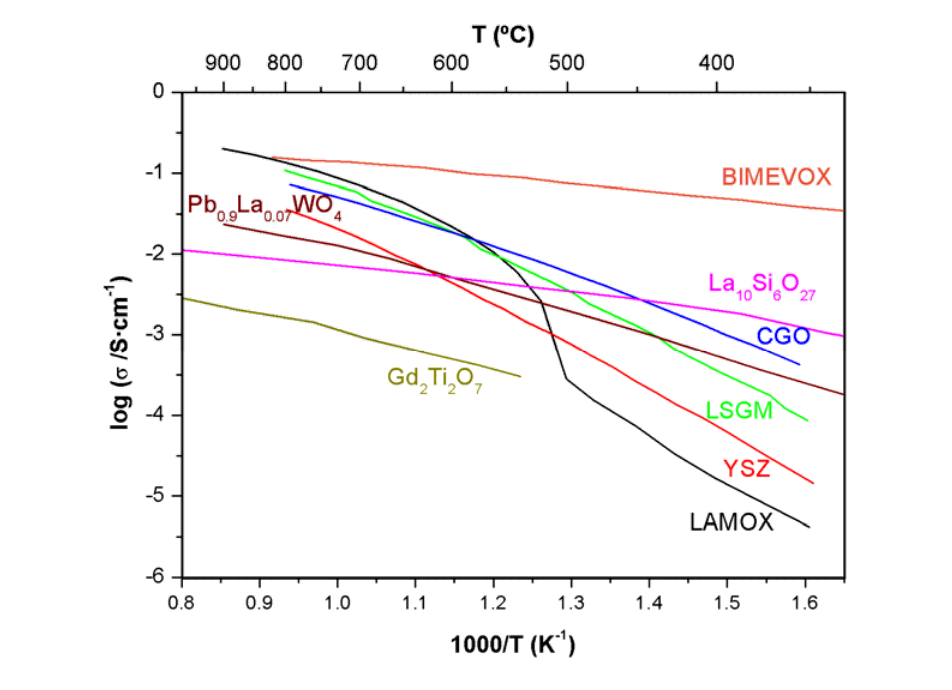
Figure 4. Conductivity dependence on inverse of temperature for different oxide ionic